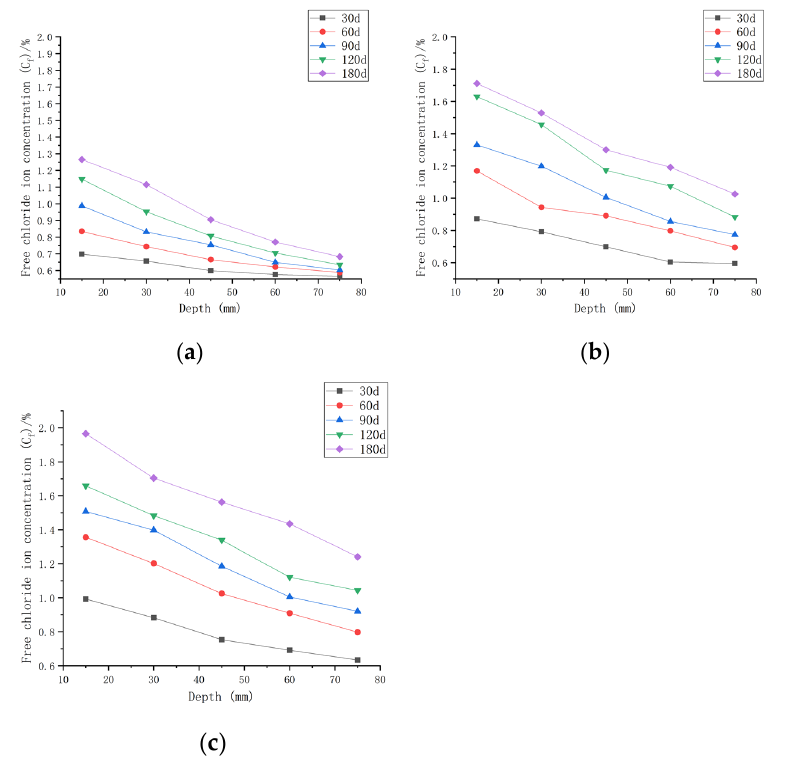
Figure 9. Relationship between free chloride ion concentration and depth of CASC with water– cement ratio 0.40 at different test times and loads. ( a ) Load is 0; ( b ) load is 0.1; ( c ) load is 0.2. The Chloride Ion Transport Law under the Same Water–Cement Ratio and Different